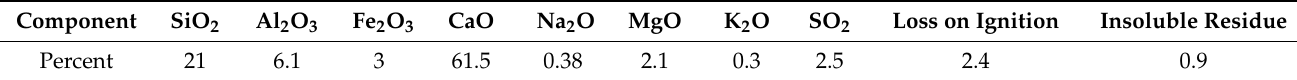
Figure 3. Grading curve for the coarse aggregate. Table 5. Chemical analysis of the